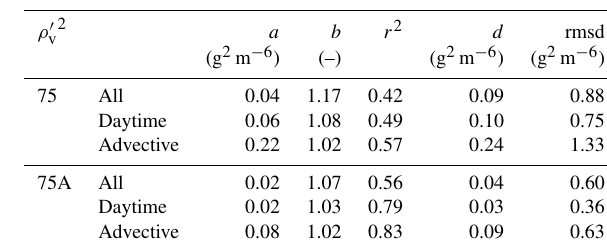
Table 1. Performance characteristics of LI-7500A and LI-7500 with reference to the LI-7500RS for water vapor variance ρ (cid:48) v2 . These include regression offset value ( a ), regression slope ( b ), coefficient of determination ( r 2 ), mean absolute bias ( d ), and comparability